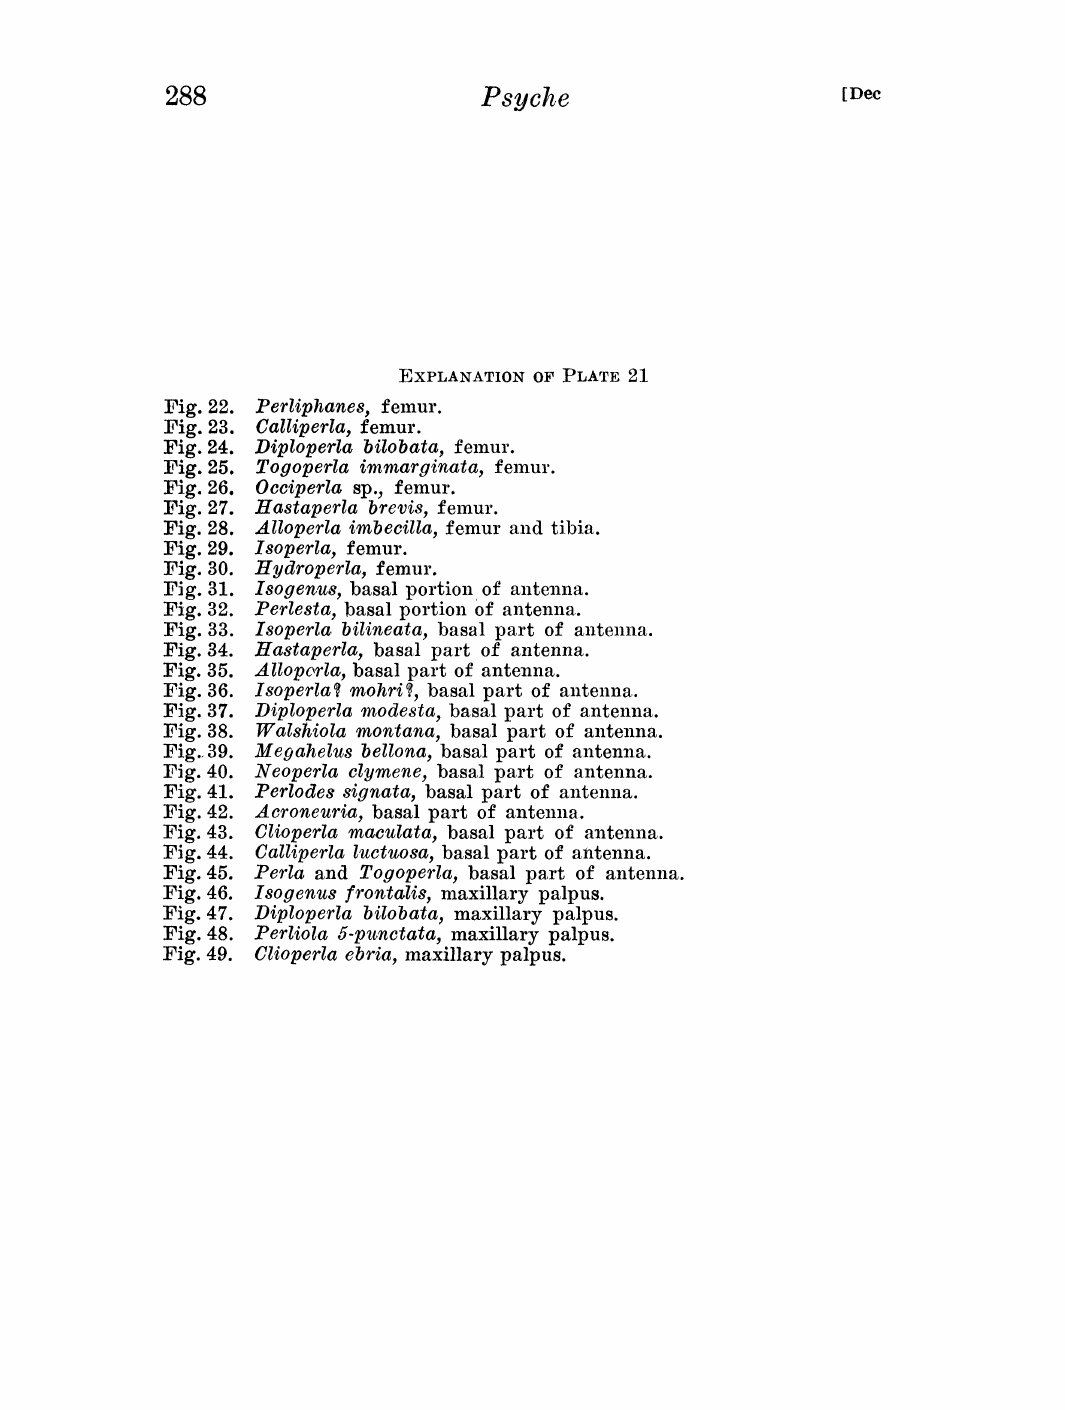
Fig. 22. Perliphanes, femur. Fig. 23. Calliperla, femur. Fig. 24. Diploperla bilobata, femur. Fig. 25. Togoperla immarginata, femur. Fig. 26. Occiperla sp., femur. Fig. 27. Hastaperla brevis, femur. Fig. 28. Alloperla imbecilla, femur and tibia. lig. 29. Isoperla, femur. lig. 30. Hydroperla, femur. Fig. 31. Isogenus, basal portion, of antenna. Fig. 32. Perlesta, basal portion of antenna,. Fig. 33. Isoperla bilineata, basal part of antenna. Fig. 34. Hastaperla, basal part of antenna. Fig. 35. Allopcrla, basal part of antenna. Fig. 36. Isoperla? mohri?, basal part of antenna,. Fig. 37. Diploperla modesta, basal part of antenna. Fig. 38. Walshiola montana, basal part of antenna. Fig.,39. Megahelus bellona, basal part of antenna. Iig. 40. Neoperla clymene, basal part of antenna. Fig. 41. Perlodes signata, basal part of antenna. Fig. 42. A croneuria, basal part of antenna. Fig. 43. Clioperla maculata, basal part of antenna. Fig. 44. Calliperla luctuosa, basal part of antenna. Fig. 45. Perla and Togoperla, basal part of antenna. Fig. 46. Isogenus frontalis, maxillary palpus. Fig. 47. Diploperla bilobata, maxillary palpus. Fig. 48. Perliola 5-punctata, maxillary palpus. Fig. 49. Clioperla ebria, maxillary